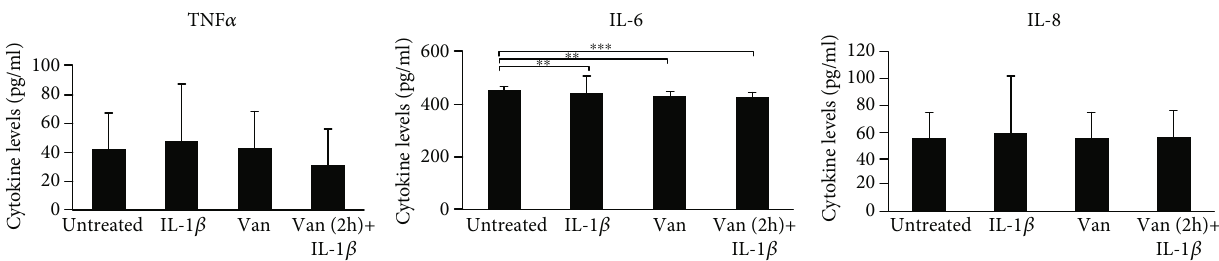
Figure 7: Levels of TNF- α , IL-6, and IL-8 in supernatant of HGF scratched cells. Data are reported as mean and 95% CI, of three independent experiments. ∗∗ p < 0 : 01 ; ∗∗∗ p < 0 : 001 . IL-1 β : IL-1 β -primed cells; Van: Vanillin; Van (2 h)+IL-1 β : Vanillin (2 h pretreatment) plus IL-1 β